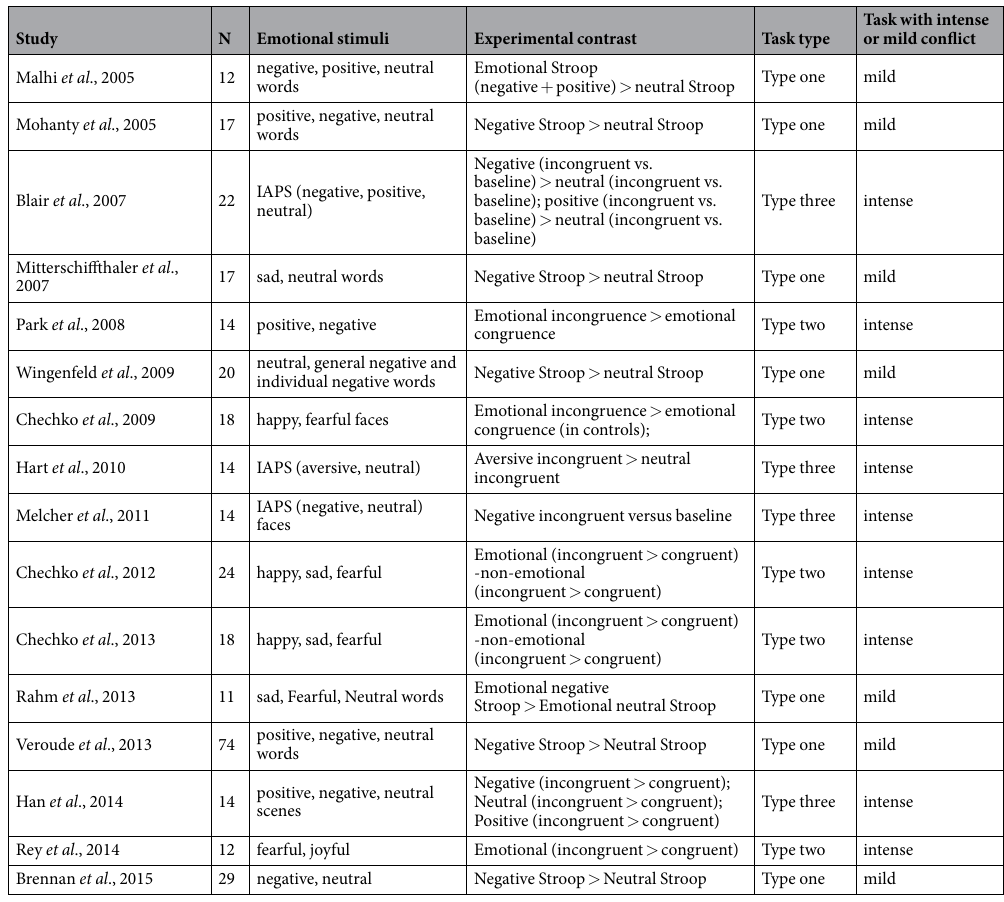
Table 3. Characteristics of studies included in meta-analysis. N: number of participants. Type one: “color-word” emotional Stroop task; type two: “word-face” emotional Stroop task; type three: “priming” emotional Stroop